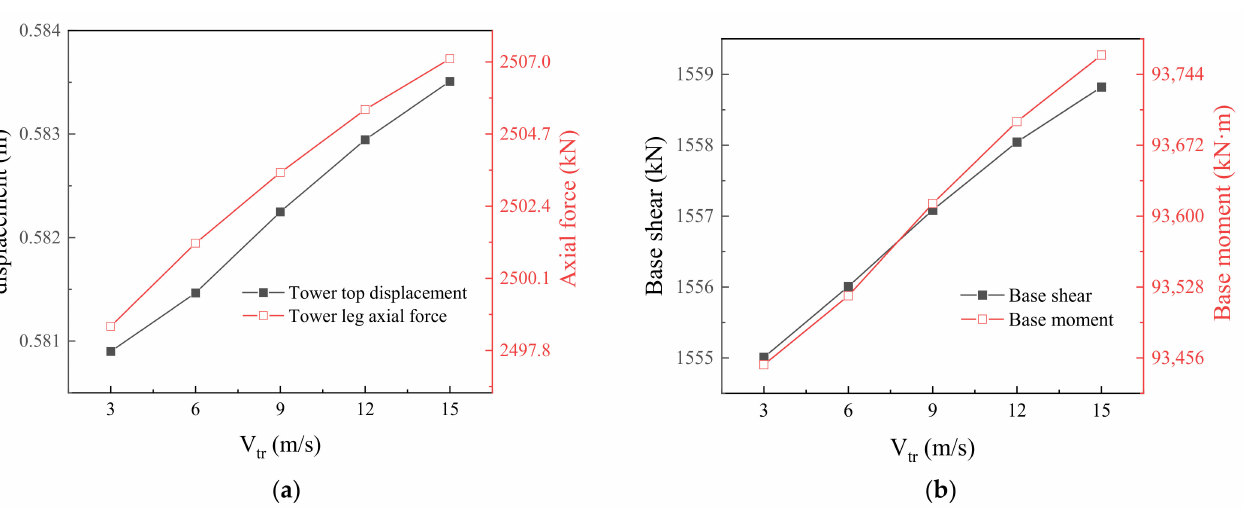
Figure 16. Wind-induced response of tower-line system changes with V t : ( a ) tower top displacement and tower leg axial force; ( b ) base shear and bending moment.